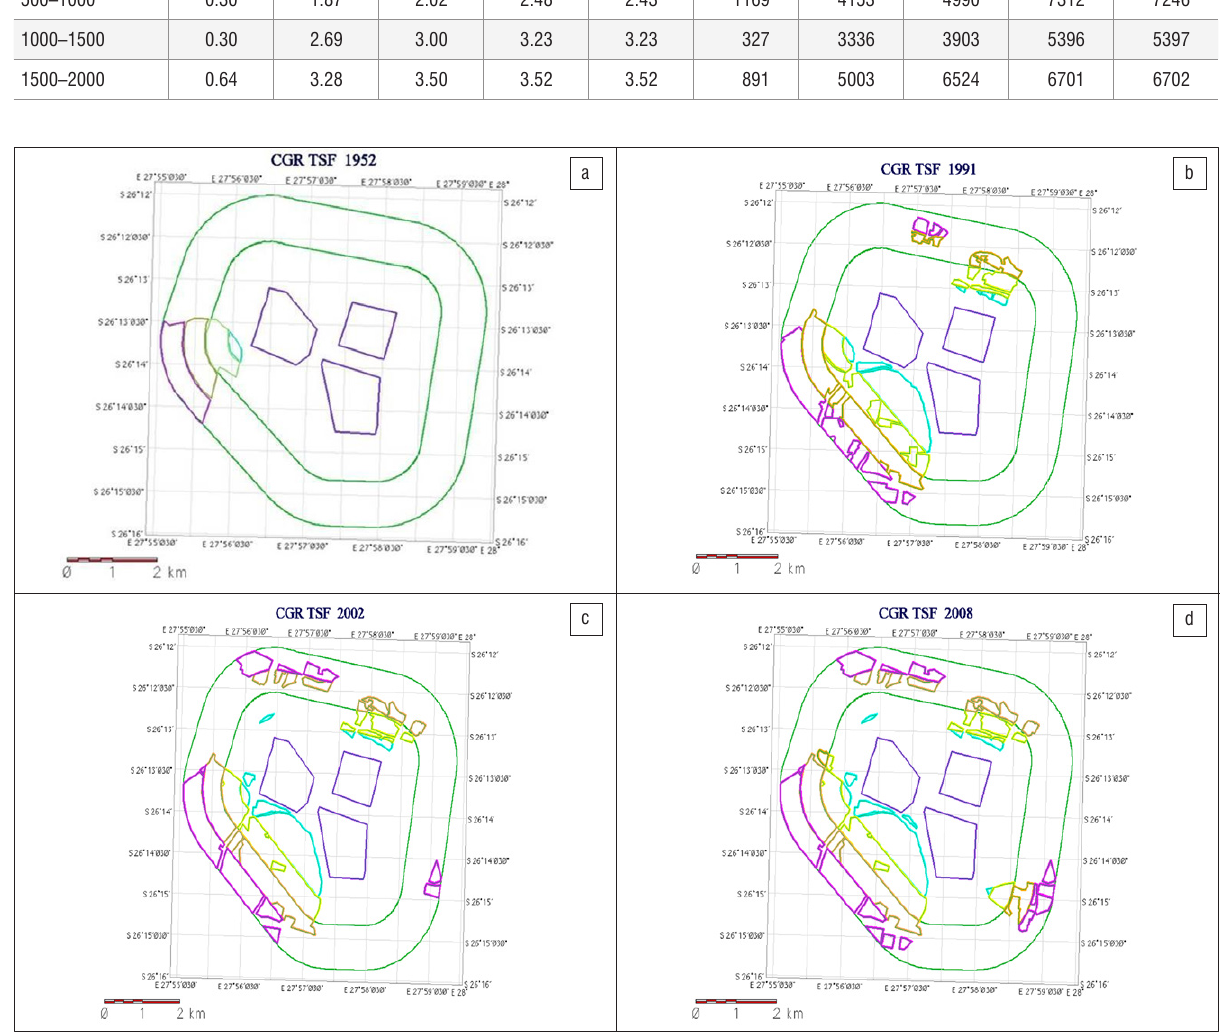
Figure 4: Time series progression of residential developments around the Crown Gold Recoveries tailings storage facilities (inner purple): (a) 1952; (b) 1991; (c) 2002 and (d) 2008. The 1 km and 2 km buffer zones are shown in dark green and the development polygons are coloured by distance from tailings storage facilities (TSF): cyan ≤ 500 m; yellow between 500 m and 1 km; orange between 1 km and 1.5 km; cerise between 1.5 and 2 km; purple = TSF footprints.